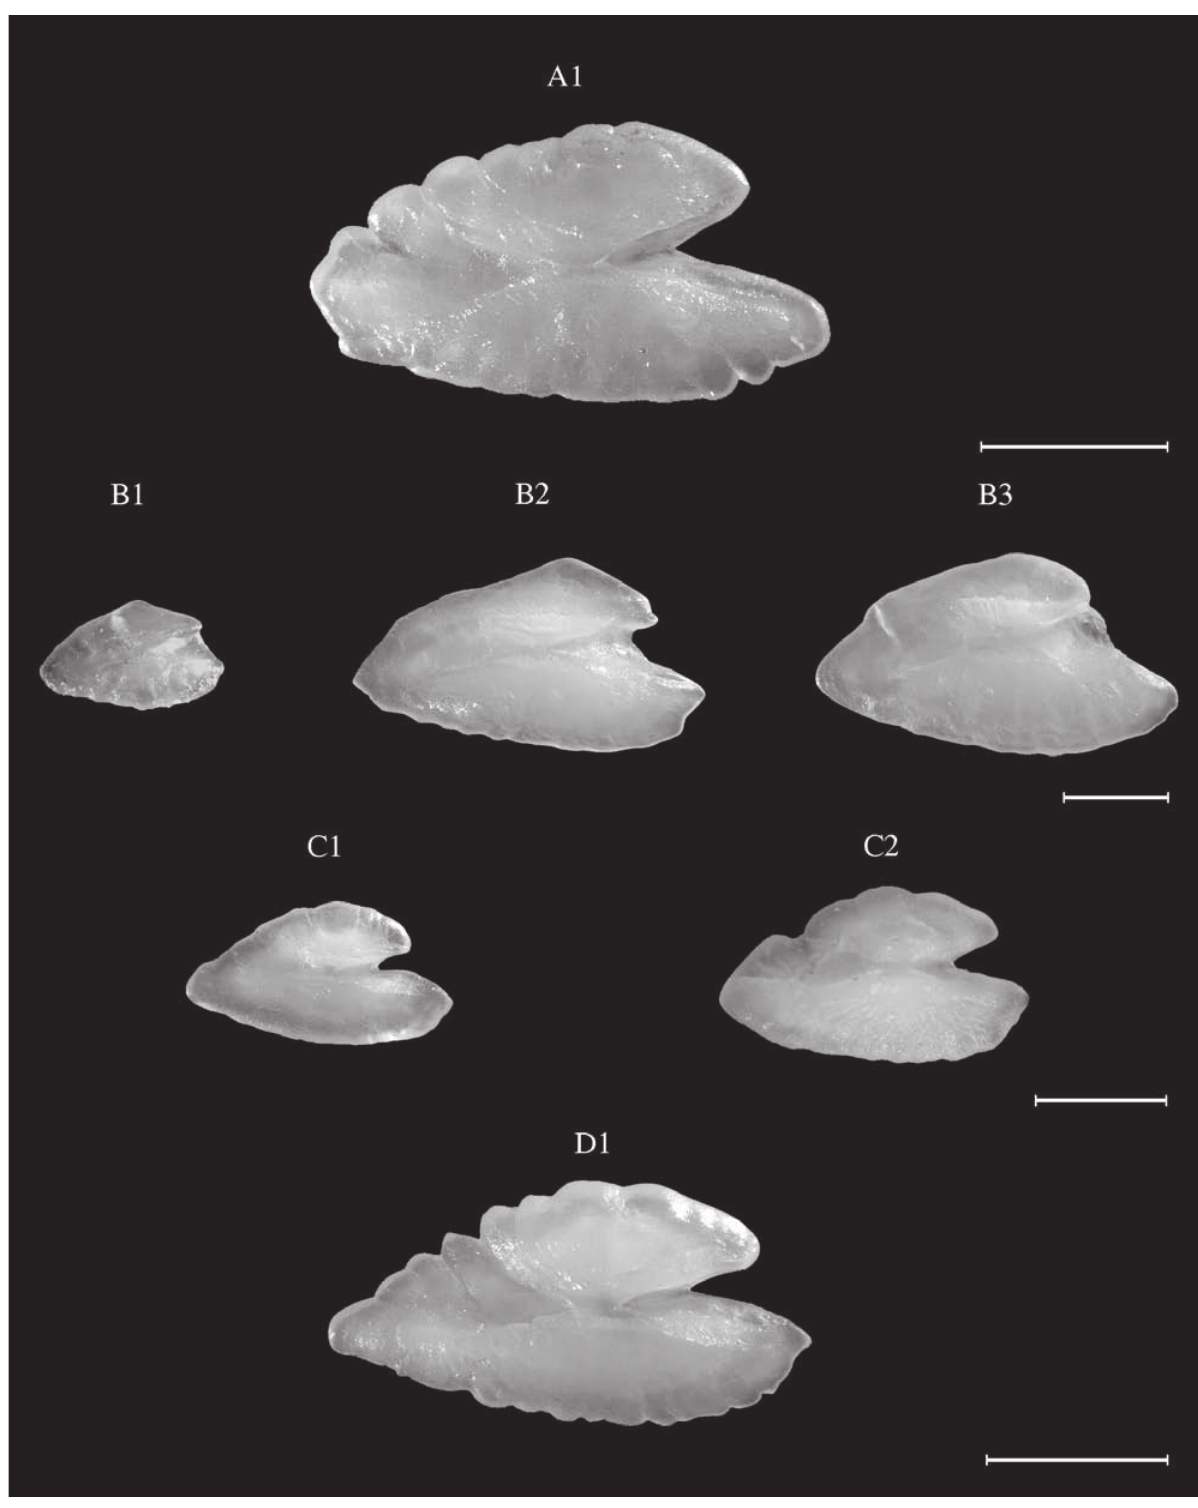
Fig. 68. – Centrolabrus trutta (NEA). TL: A1, 18.5 cm. Coris julis. TL: B1, 8.5 cm (WM); B2, 17.8 cm (NEA); B3, 22.7 cm (NEA). Ctenolabrus rupestris (NEA). TL: C1, 8.9 cm. Labrus bergylta (NEA). TL: D1, 13.8 cm. Scale bar = 1